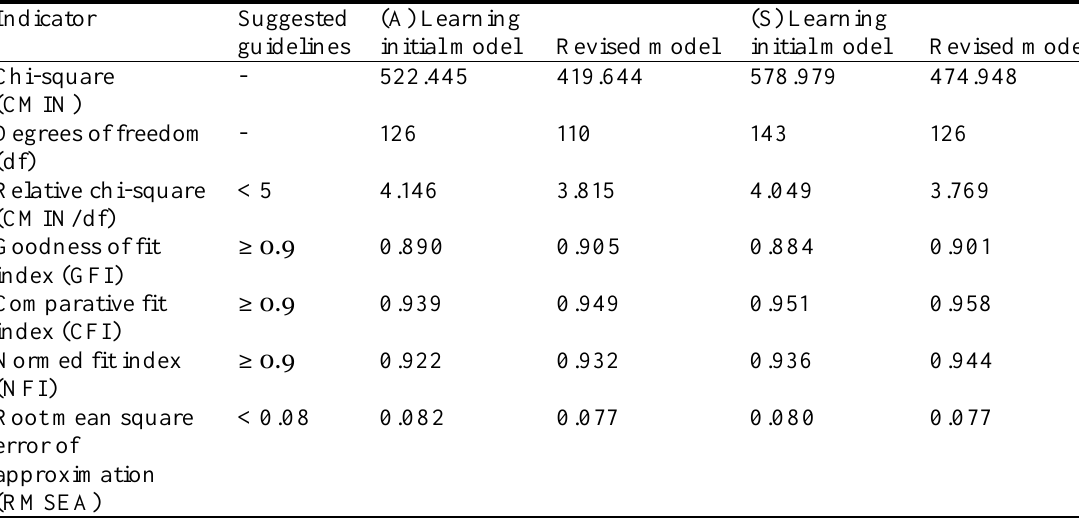
Table 3 Model Fit Indicators of the Initial and Revised Models during Asynchronous (A) and Synchronous (S) Learning